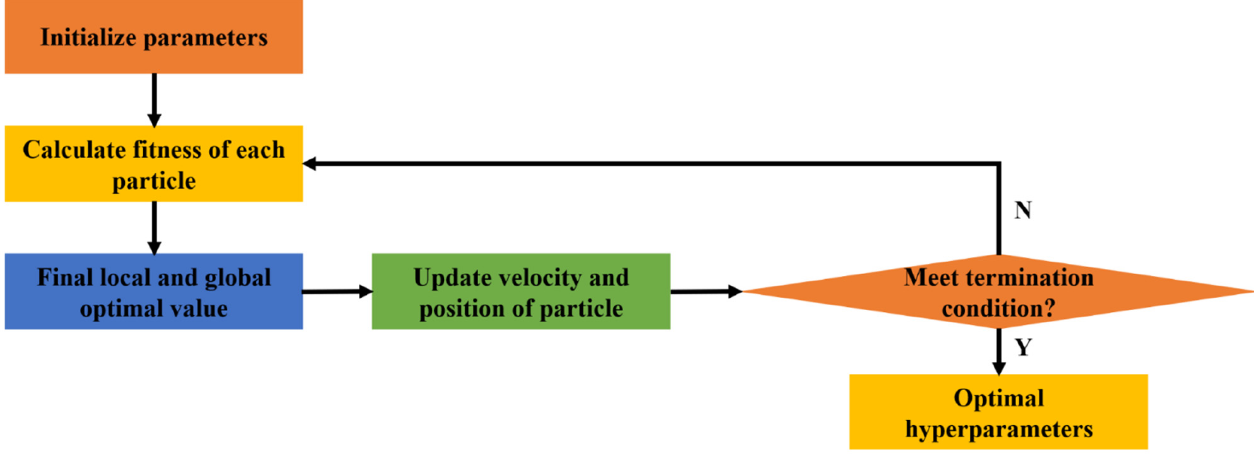
Figure 8. Flowchart of PSO.